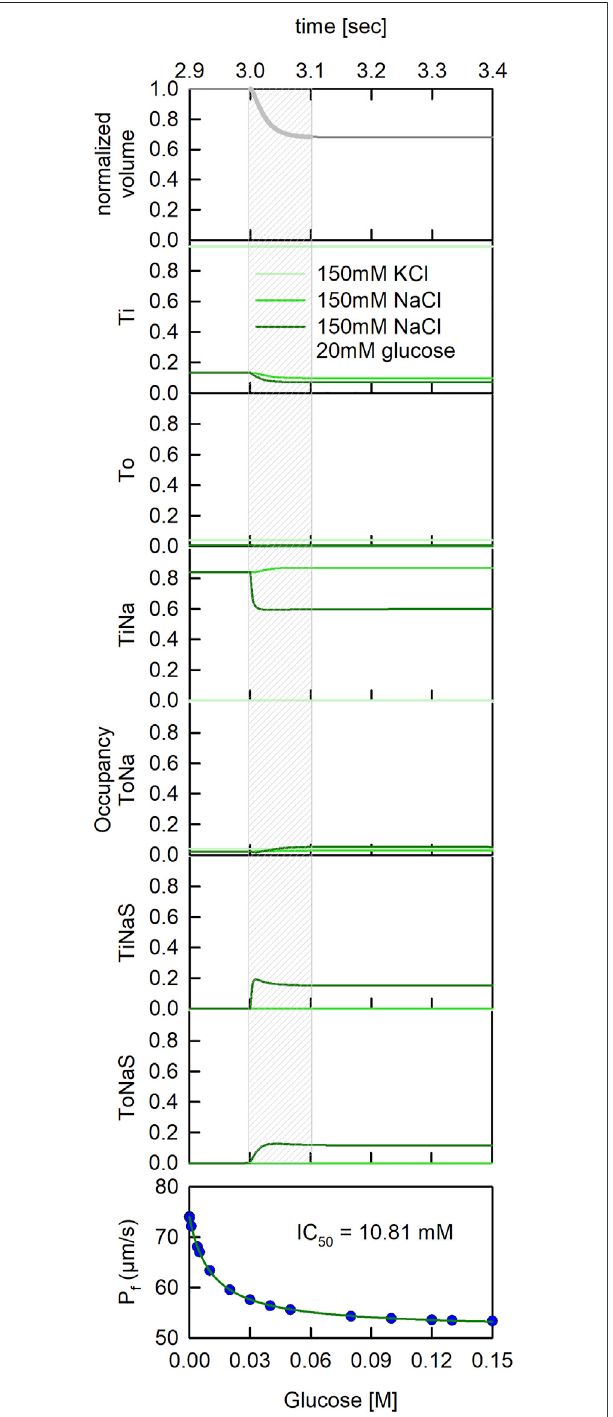
FIGURE 6 | Dynamic changes of state occupancies in a stopped fl ow experiment. State occupancies of SGLT1 before and after application of a hyperosmotic gradient (at time t = 3 s). We simulated three different experimental conditions: (light green line) PLs reconstituted in 150 mM KCl buffer and subjected to a 150 mOsm sucrose gradient, (green line) PLs reconstituted in 150 mM NaCl buffer and subjected to a 150 mOsm sucrose